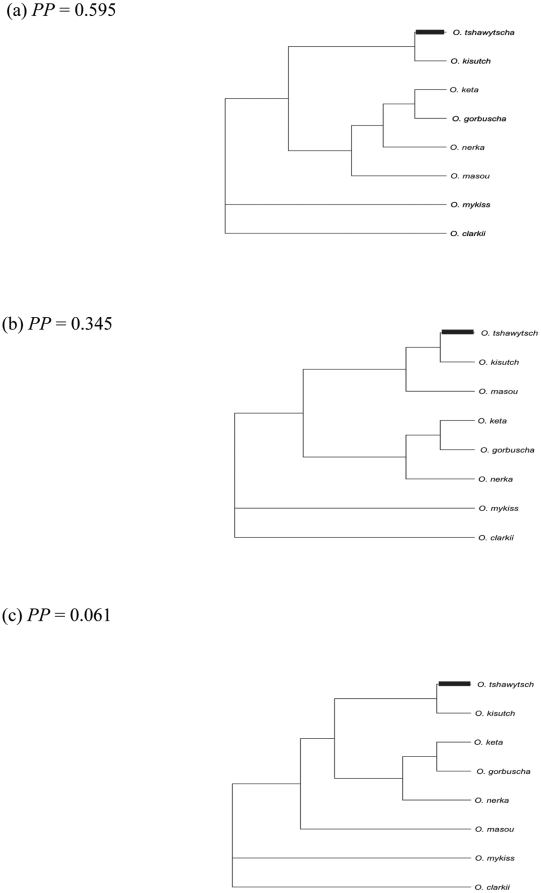
Phylogenetic Trees inferred using MrBayes.Phylogenetic trees estimated from the mtDNA coding sequence data from eight species of Pacific salmon. The Bayesian analysis predicted three trees with posterior probabilities of (a) 0.595, (b) 0.343, and (c) 0.061. The foreground branch for the branch-site analysis is identified with a bold line. Trees were drawn without distances because Mr. Bayes estimates distances for only the most probable tree.